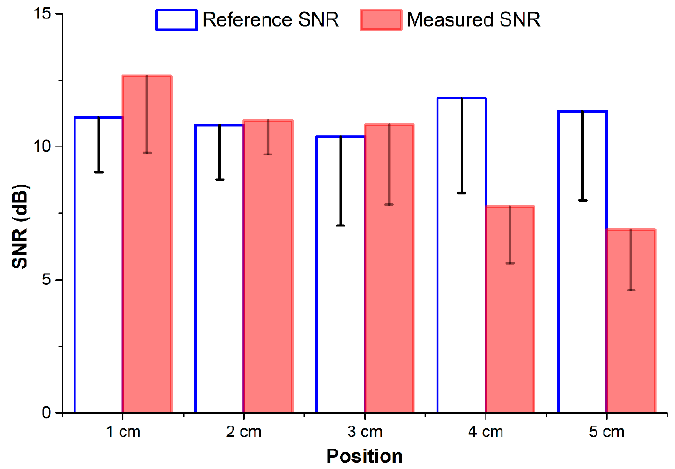
Figure 8. SNR values of the commercial device and the proposed BI measurements at various locations.